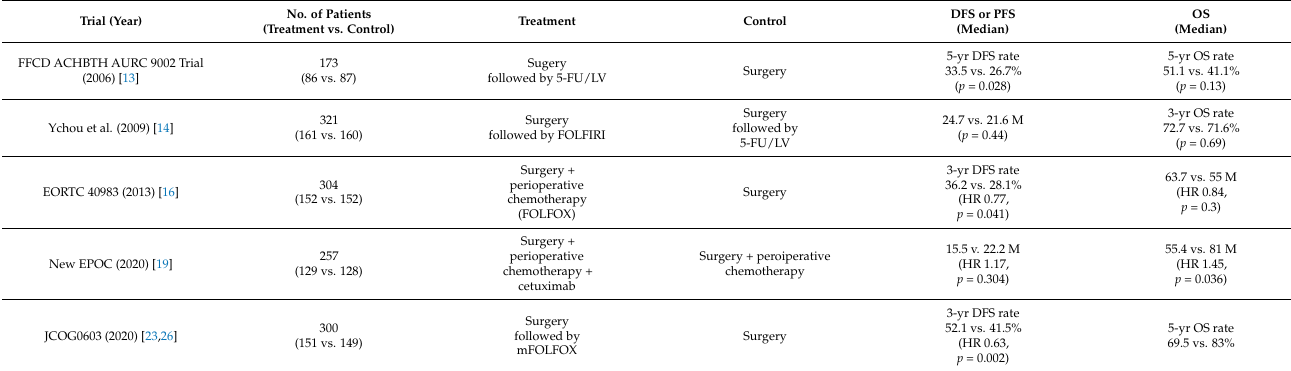
Table 1. Clinical trials investigating resectable colorectal cancer with liver